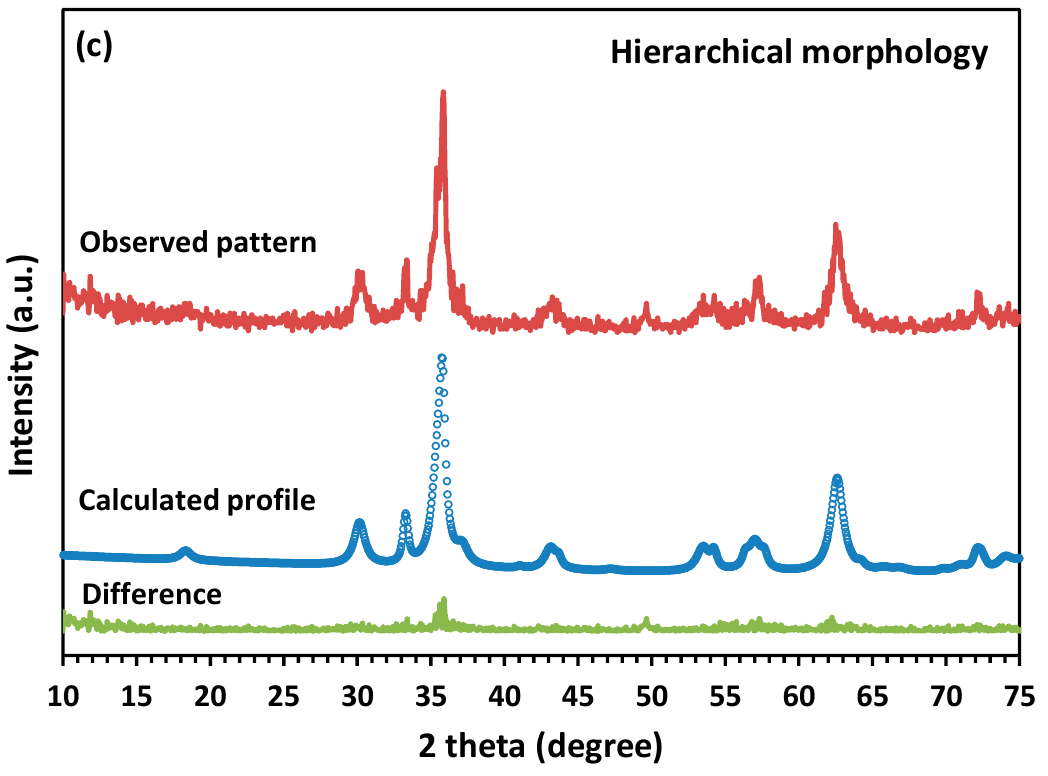
Figure 1. ( a ) XRD patterns of synthesized MnZn ferrites with different morphologies, and ( b ), and ( c ) corresponding Rietveld refined XRD patterns.